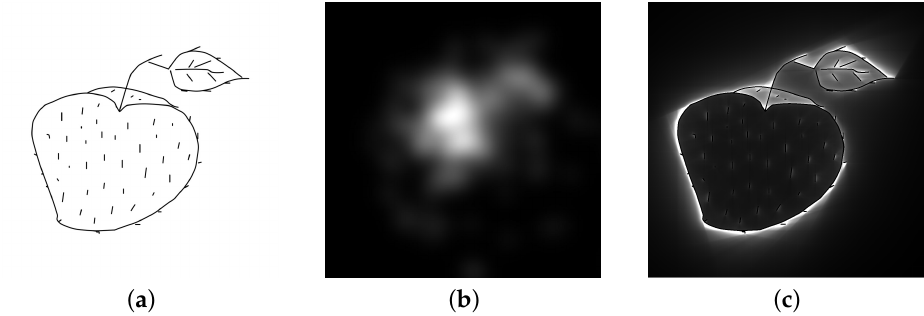
Figure 1. Example of the fixation map [16] and the psychological potential field (PPF): ( a ) stimulus image; ( b ) fixation map; and ( c ) psychological potential